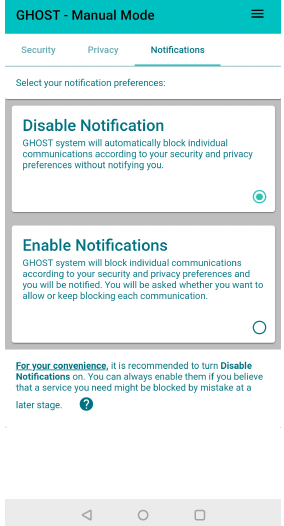
Figure 10. Notification